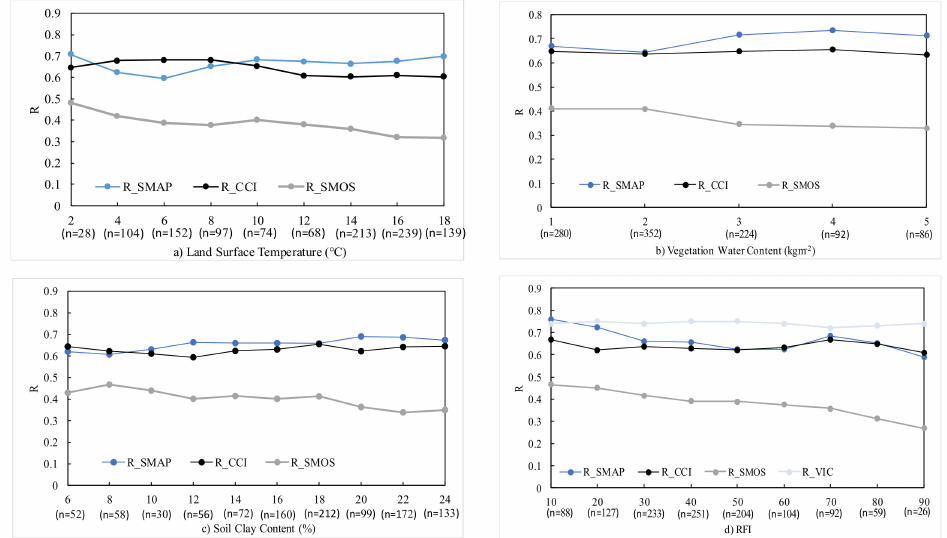
Figure 9. Performance of R for SMAP, CCI, and SMOS soil moisture product considering ( a ) land surface temperature; ( b ) vegetation water content; ( c ) soil clay content; ( d ) Radio Frequency Interference (RFI). The n in parentheses represents the number of sites in the corresponding impact